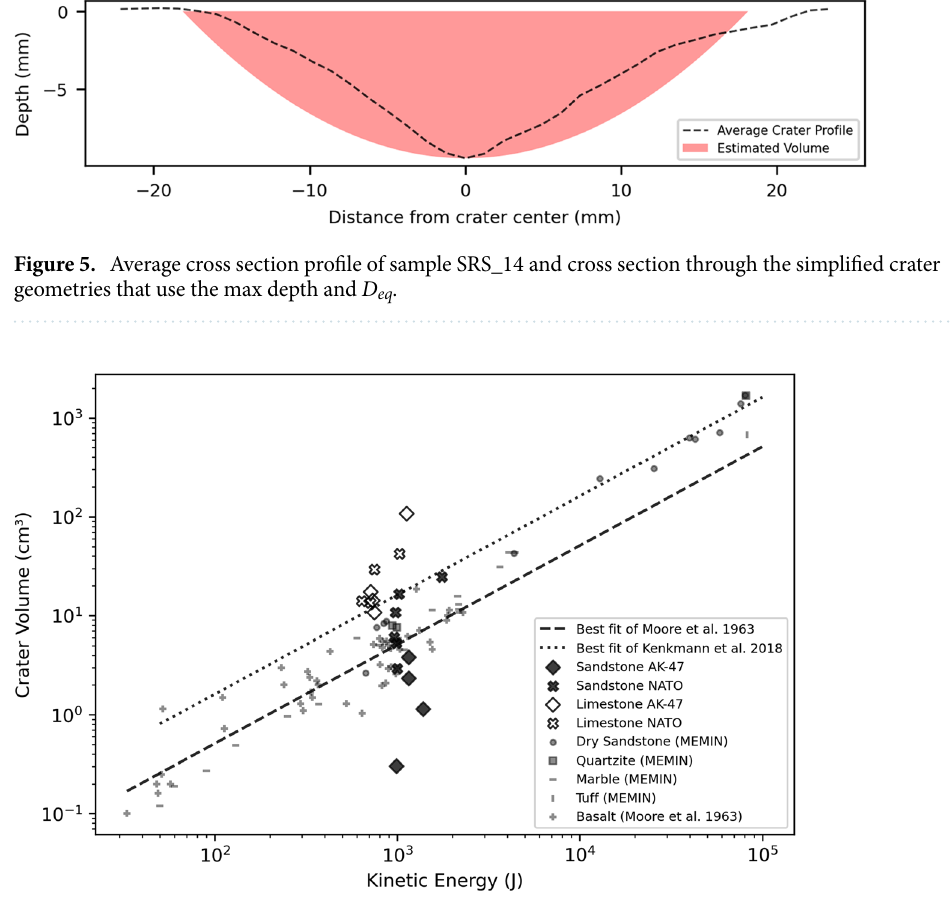
Figure 6. Plot showing the trend of increasing crater volume with increasing kinetic energy (at impact) displayed by hypervelocity experiments from Moore et al. 44 and the Multidisciplinary Experimental and Modelling Impact Crater Research Network (MEMIN) 43 . The results of this study have a wider range of crater volumes for the narrow range of impact energies studied, particularly impacts into sandstone with 7.62x 39 mm (AK-47) projectiles. NATO = 5.56 x 45mm NATO